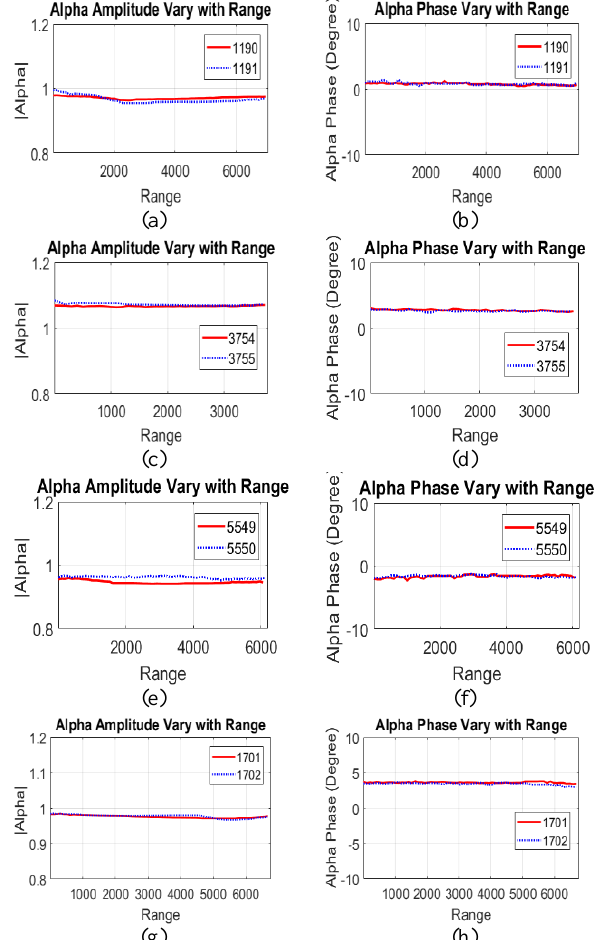
Figure 1. The residual Alpha Amplitude and Alpha Phase error in the image. The legend denotes the image number. Figure (a), (c), (e), (g) show the Alpha Amplitude error; Figure (b), (d), (f), (h) show the Alpha Phase